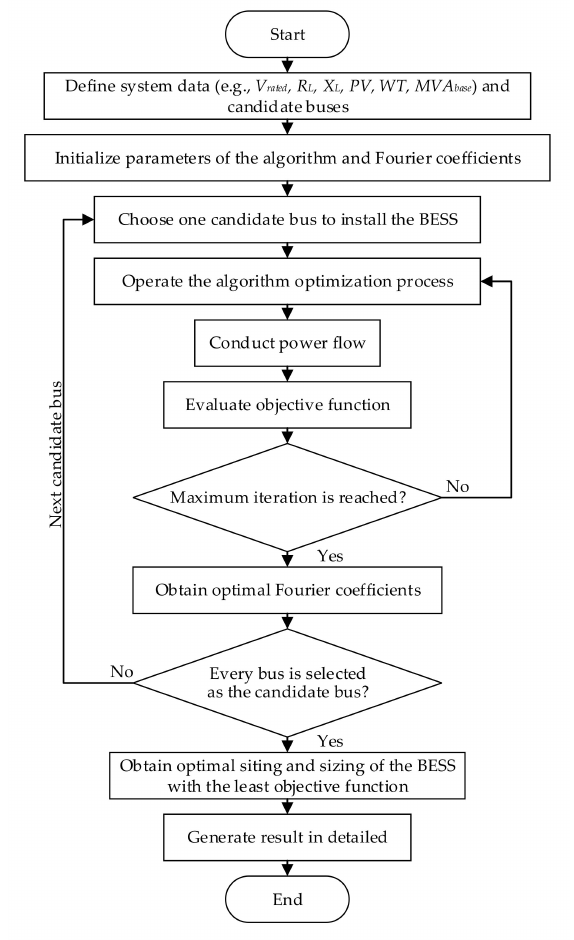
Figure 2. Flowchart of the proposed